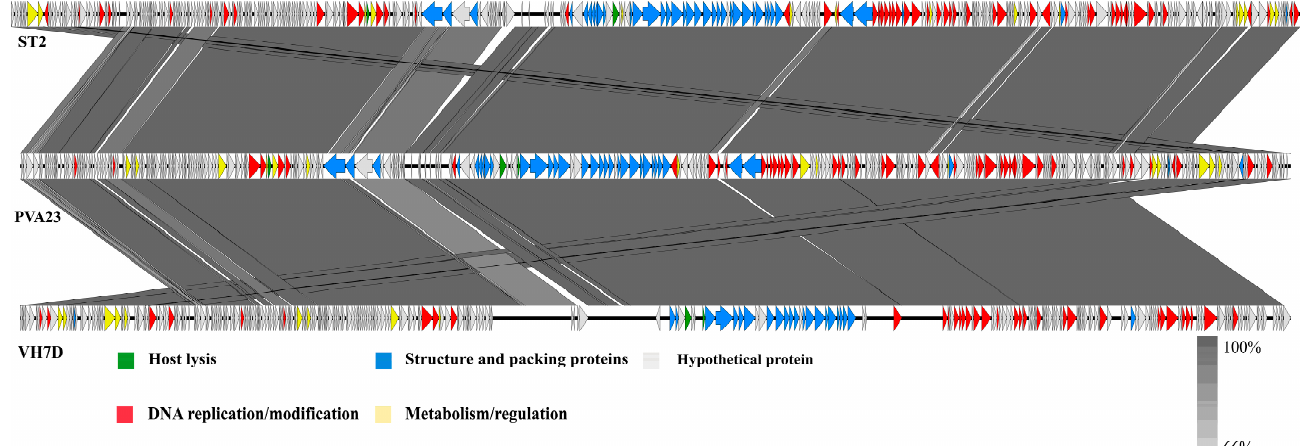
Figure 9. Comparative genome map of a multiple-genome comparison (amino acid level) performed using Easyfig software. Open reading frames (ORFs) are shown as arrows to indicate the direction of transcription and are colored in accordance with their predicted functions: DNA replication/modification (red arrows), structure protein and packing proteins (blue arrows), metabolism/regulation (yellow arrows) and host lysis (green arrows). Gray arrows represent ORFs of unknown functions (hypothetical protein). Gray shading indicates nucleotide identity between sequences (66–100%).